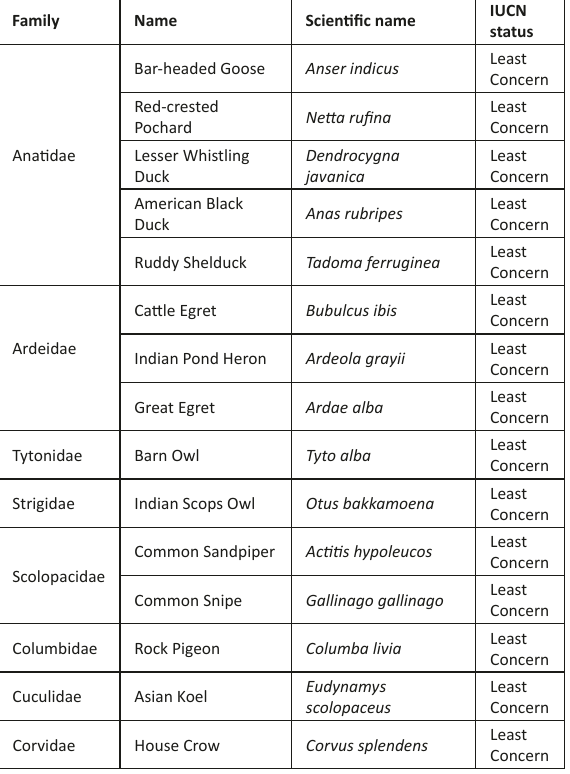
Table 1. IUCN status of the bird species collision found in location -3 (www.iucnredlist.org)